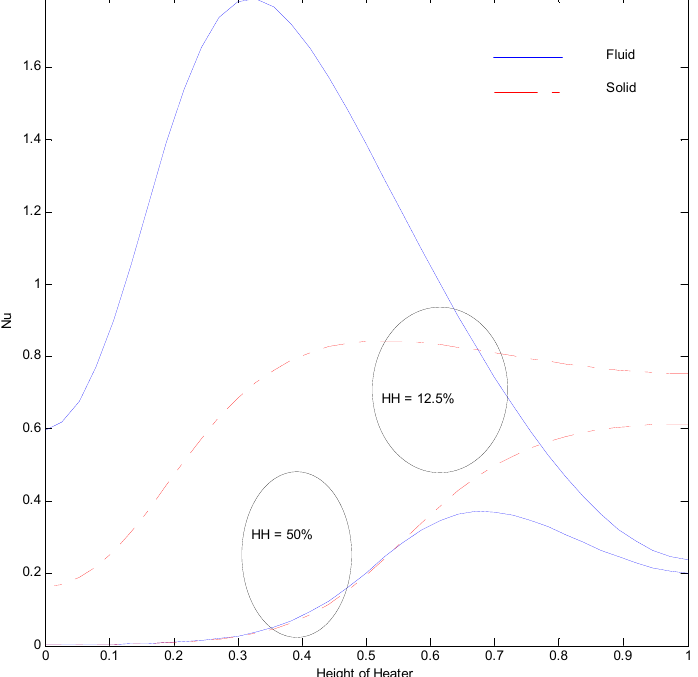
Figure 28. Nusselt number of the left vertical surface at Ra = 100, H = 5, Kr = 1, Rd = 0 for strip at x = 0.25.